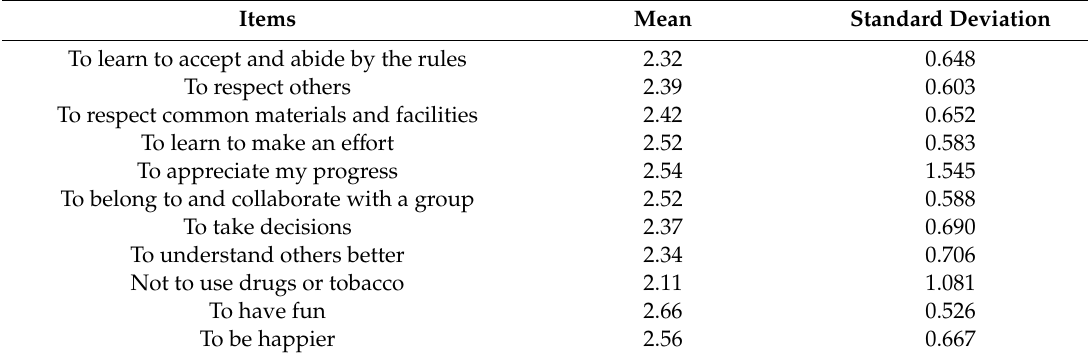
Table 4. Influence of the football program in other aspects.